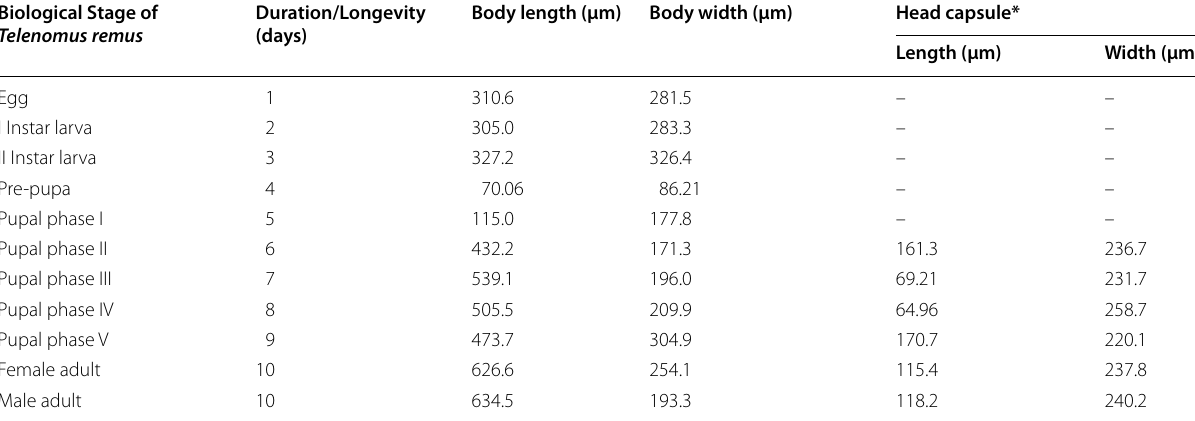
*Upto pupal phase I clear demarcation of body segments was not observed